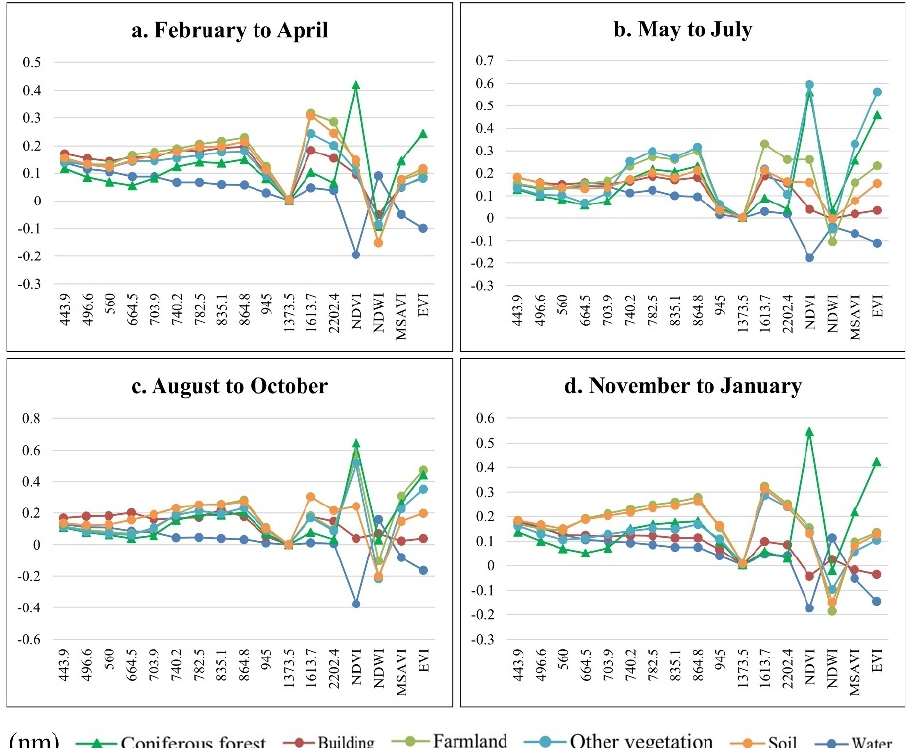
Figure 2. The spectral curves of six LULC types (coniferous forest, building, farmland, other vege- tation, soil and water); ( a ) spectral reflectance from February to April; ( b ) spectral reflectance from May to July; ( c ) spectral reflectance from August to October; ( d ) spectral reflectance from November to January.